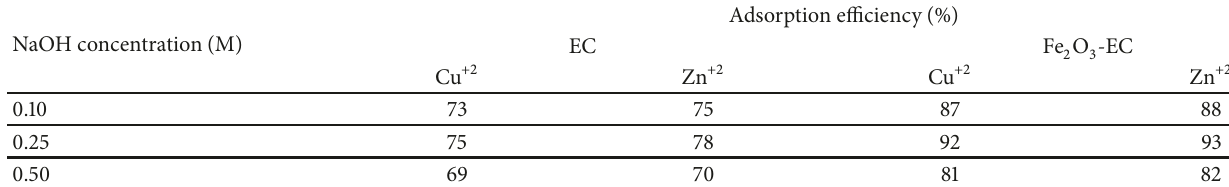
Table 5: Adsorption efficiency of adsorbents after five desorption